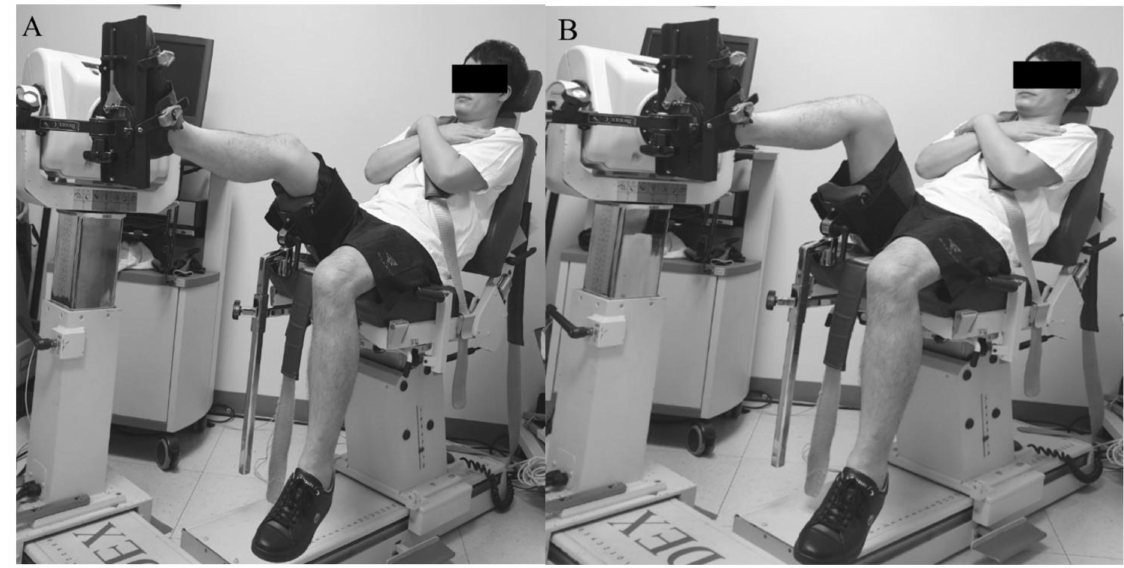
Figure 1. Measurement of gastrocnemius ( A ) and soleus ( B ) muscle strength.